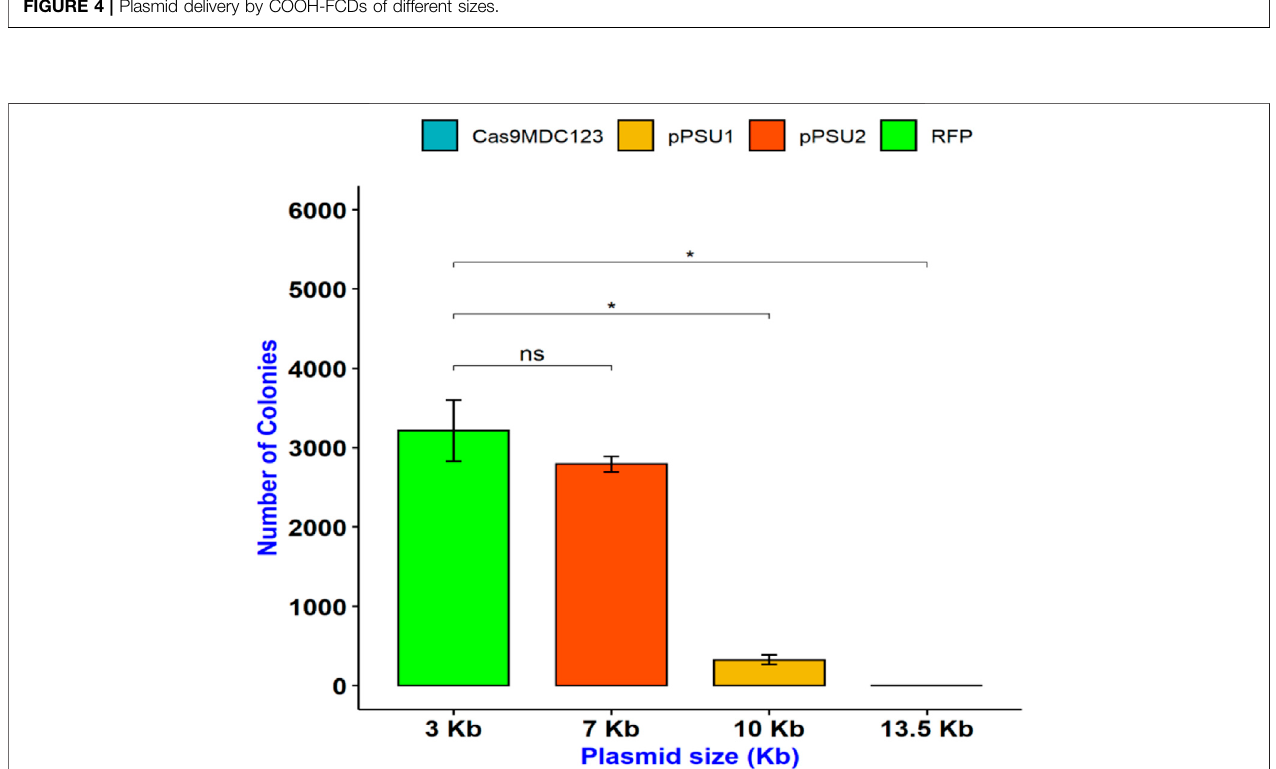
FIGURE 5 | Delivery of plasmid DNAs with different sizes in E. coli cells using COOH-FCDs. Effect of temperature on DNA delivery by COOH-CDs in E. coli.